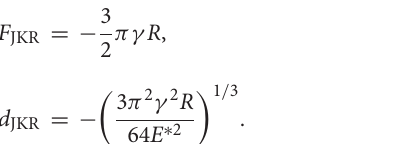
√ A con /π . At the = λ 2 /π or π a ∗ /λ √ π = = ≈ p